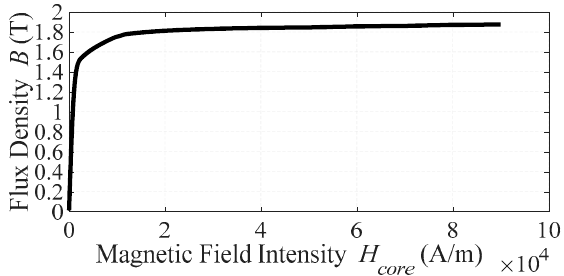
Figure 3. B-H curve of NGO 35JN200 electrical steel. Energies 2020 , 13 , x FOR PEER REVIEW